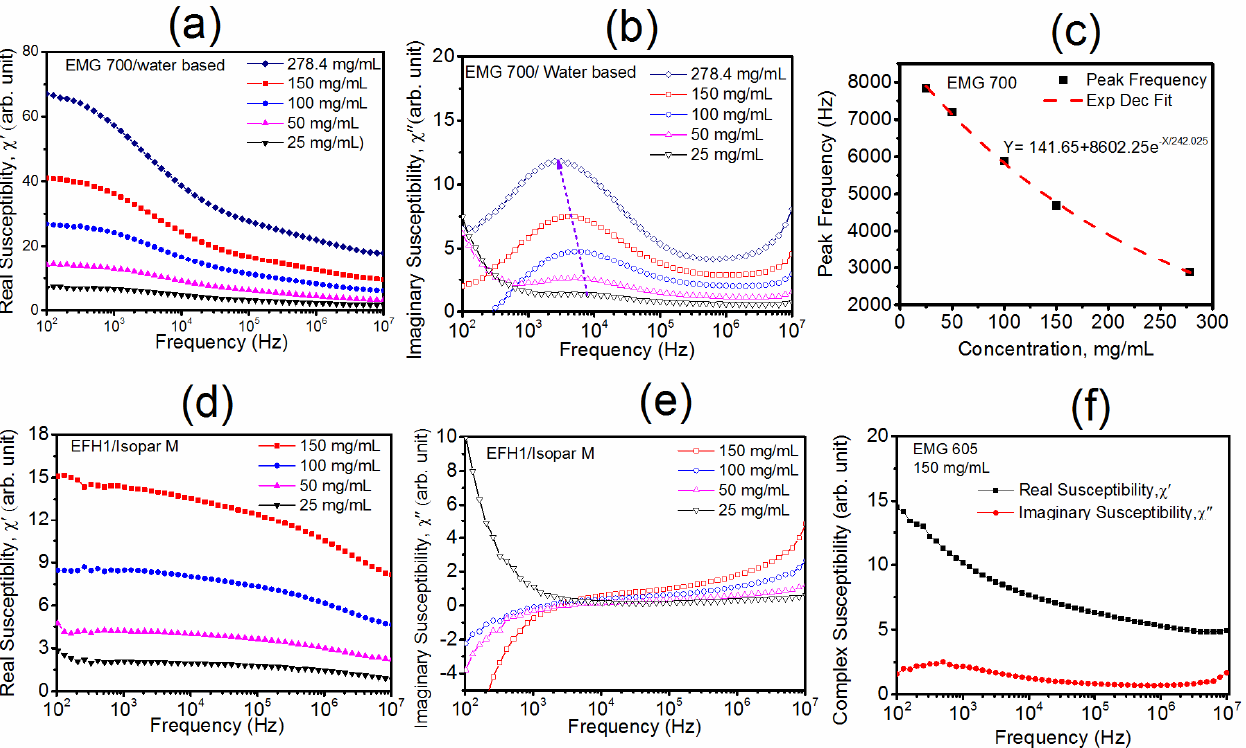
Figure 4. ( a , b ) Real ( a ) and imaginary part ( b ) of susceptibility of the water-based EMG 700 samples at different concentrations. ( c ) Fitting of the peak frequency of Brownian relaxation vs. concentration for the EMG 700 sample. ( d , e ) Real ( d ) and imaginary ( e ) part of susceptibility of the Isopar-M-based EFH1 sample at different concentrations and ( f ) complex susceptibility of the EMG 605 sample at a concentration of 150 mg/mL.